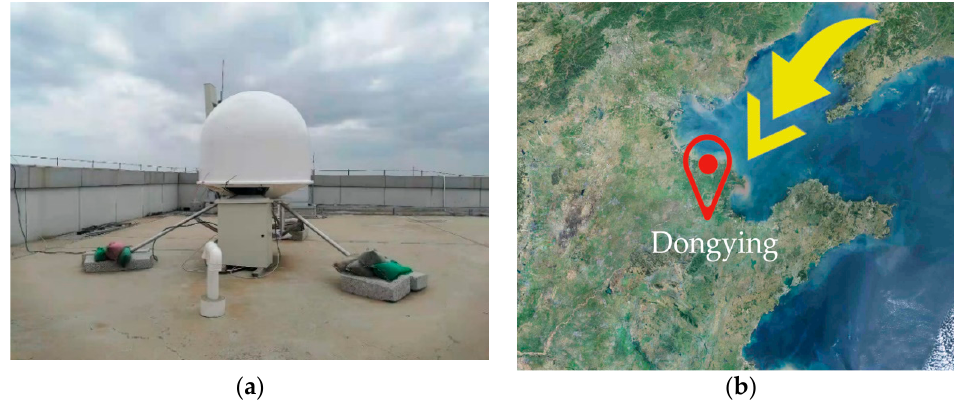
Figure 10. Ku-band, high-resolution, fully polarimetric entomological radar. ( a ) Radar scene picture. ( b ) Satellite map of the radar installation location.